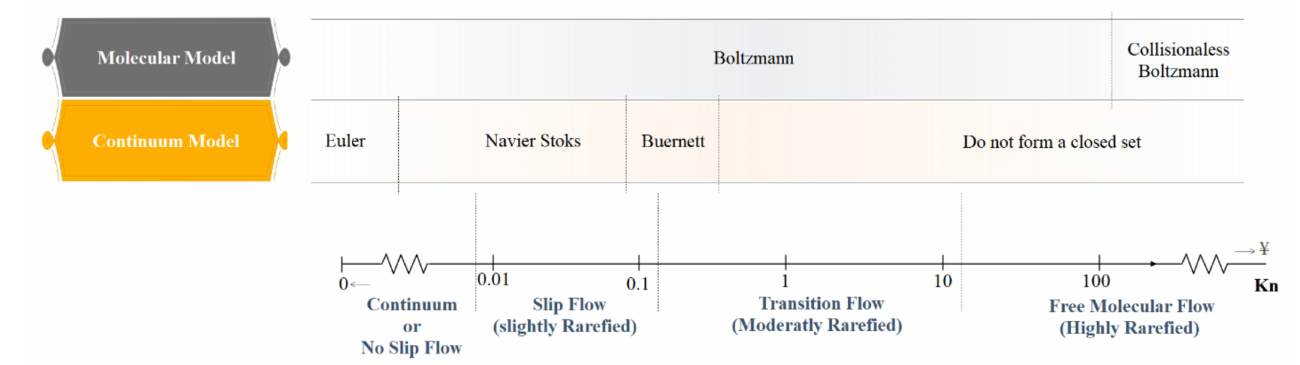
Figure 4. Equations and boundary conditions based on Knudsen number [85].